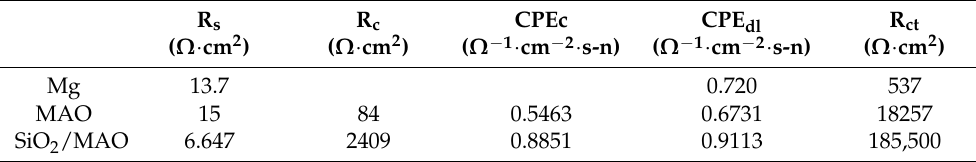
Figure 5. The electrochemical impedance spectroscopy ( a ) Nyquist plot, ( b ) Bode plot. Table 4. Fitting impedance parameters of each sample after soaking at 80 ◦ C.